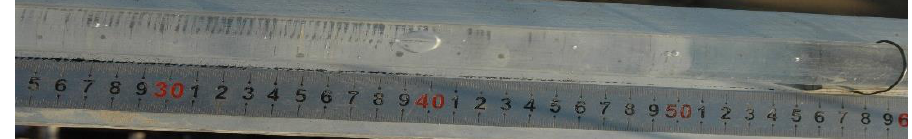
Figure 3. Measurement of the bubble velocity.